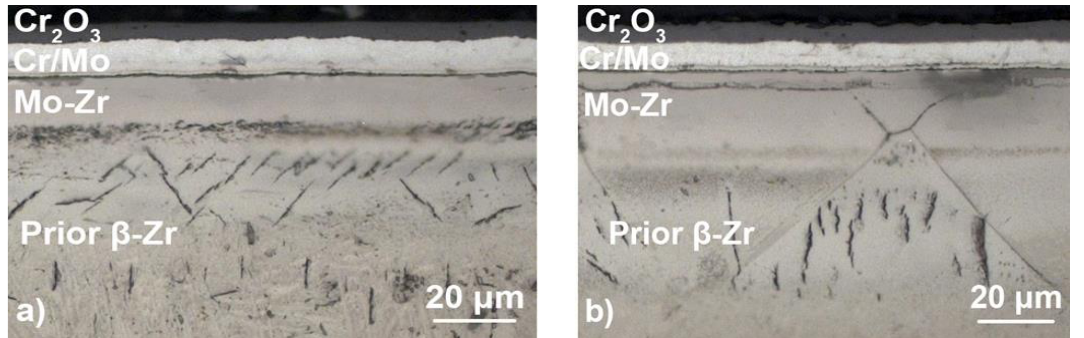
Figure 4. Cross-section optical micrographs of the Cr/Mo-coated Zr alloy samples after oxidation at 1200 °C for 1000 s ( a ) and 2000 s ( b ).